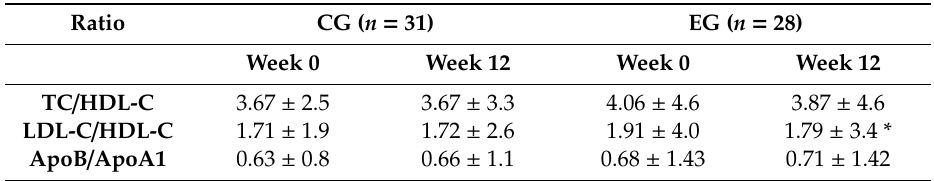
Table 3. Values of total cholesterol / high-density lipoprotein (TC / HDL), low-density lipoprotein (LDL) / HDL and apolipoprotein B / apolipoprotein A1 (ApoB / ApoA1) ratios before and after the